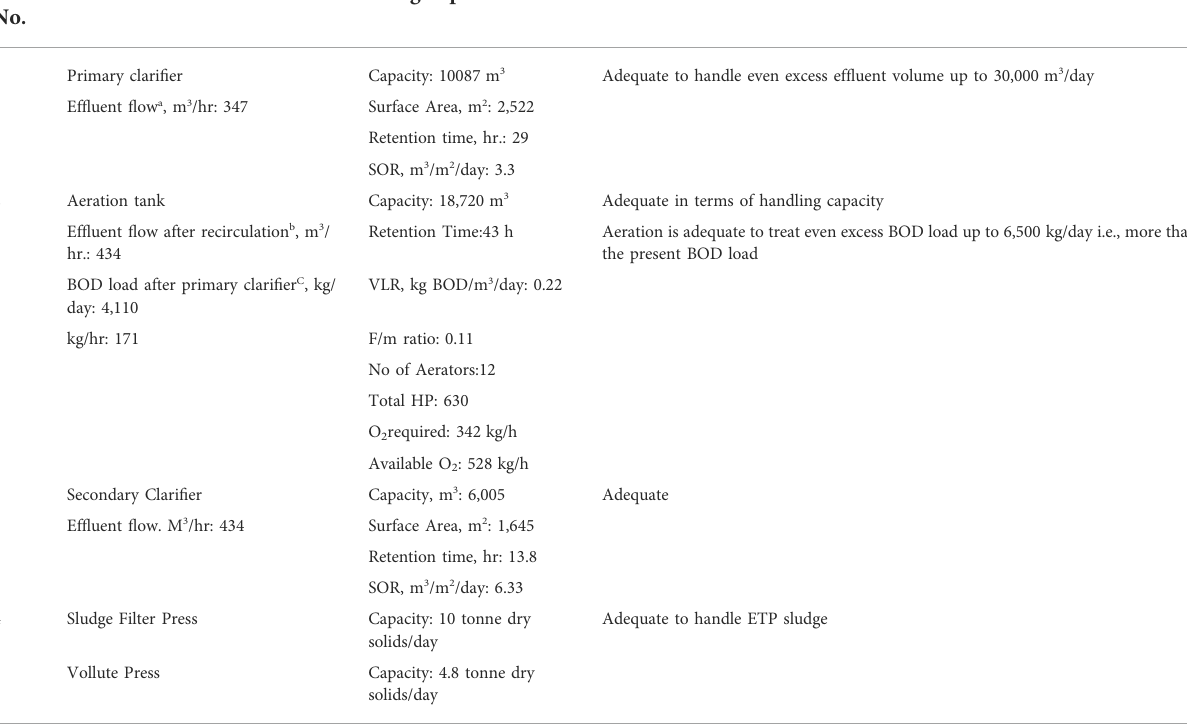
TABLE 6 Adequacy assessment of ETP at star paper mills Ltd.